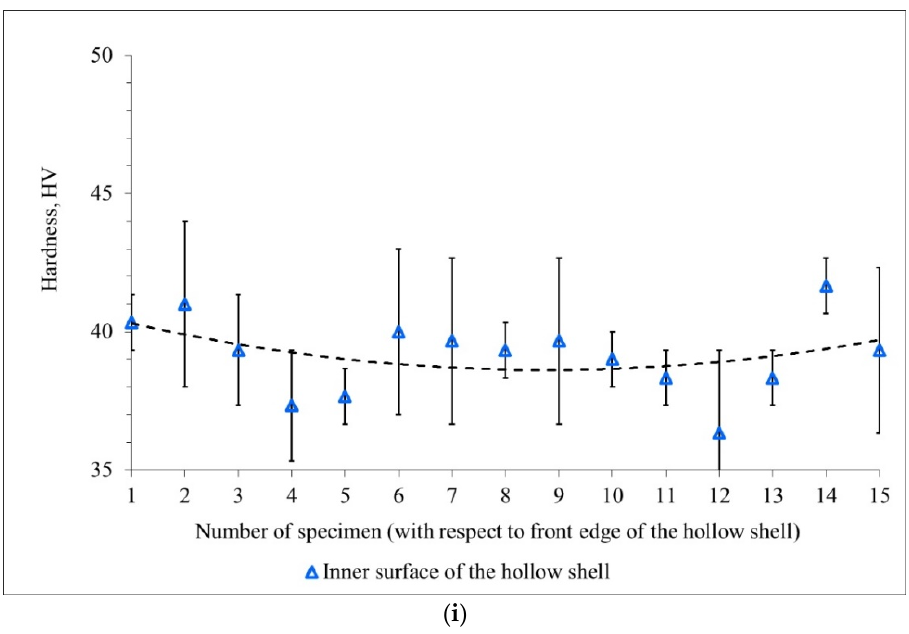
Figure 9. Hardness changing in the longitudinal section of the hollow shells pierced by the entire plug ( a – c ), the plug with a cavity ( d – f ), and the hollow plug ( g – i ).